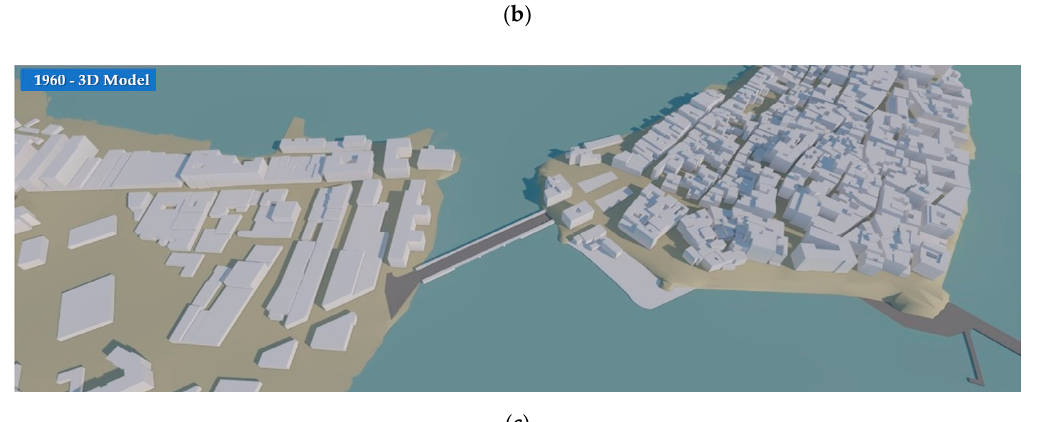
Figure 13 . 3D models: ( a ) 1910, ( b ) 1938, ( c ) 1960.